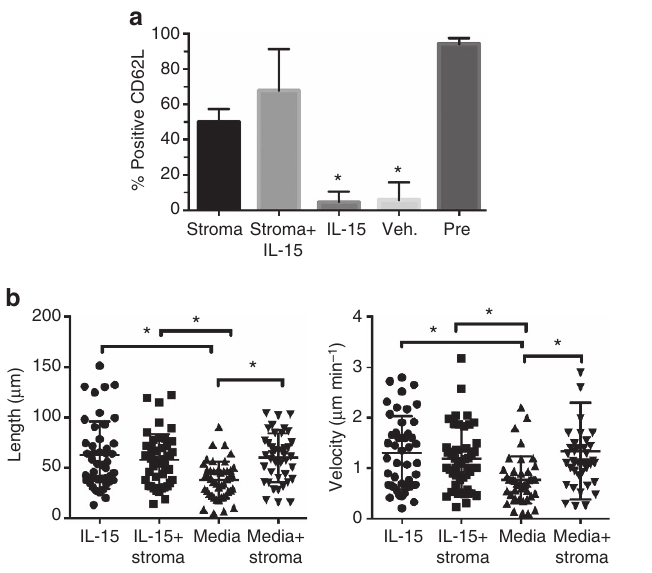
Figure 6 | CD62L expression on mature NK cells is reduced in the absence of EL08.1D2 stromal cells. CD56 bright NK cells were purified and incubated on EL08.1D2 stromal cells or in uncoated tissue culture dishes for 3 days in the presence of 5ngml (cid:2) 1 IL-15 or vehicle control. ( a ) Percentage of NK cells expressing CD62L as determined by FACS ( n ¼ 3 wells from three independent experiments for each condition) * P o 0.05 when compared to stroma þ IL-15 condition by unpaired Student’s t -test. EL08.1D2 for 4h before the initiation of imaging. Cells were imaged and tracked as in Fig. 1. n ¼ 45 from two independent experiments. P o 0.0001 All data are represented as mean ± s.d.